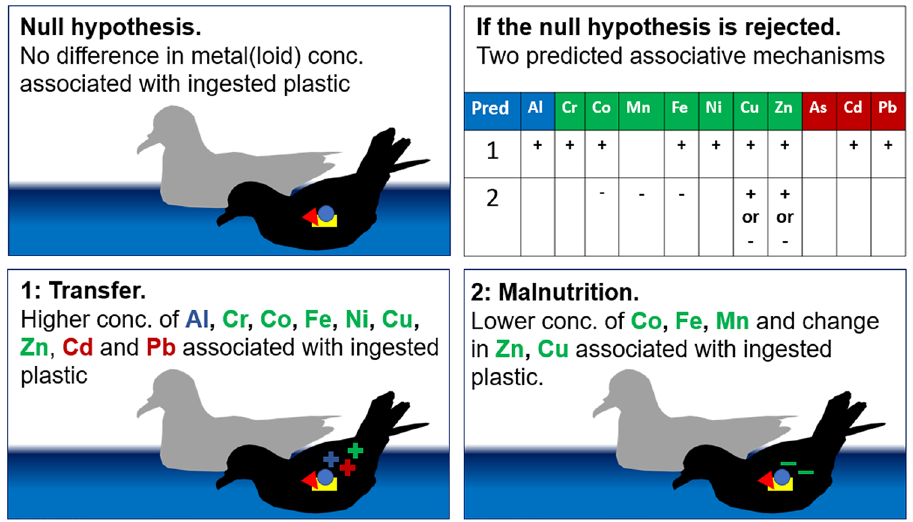
Figure 2. Predictions for the association of plastic with the liver metal concentration of prions, though pre-storm body condition is unknown. The null hypothesis is that there is no difference in liver metal(loid) concentration between prions with and without ingested plastic. Significant differences in the concentration of liver metal(loid)s leads to rejection of the null hypothesis and examination of support for two mechanistic association predictions derived from the literature: transfer of metal(loid)s from plastic or malnutrition due to dietary dilution by plastic in the gut. Essential metals are shown in green, non-essential metals are shown in red, and metals where the biological role is unclear are shown in blue. Prion silhouettes were created using GIMP 88